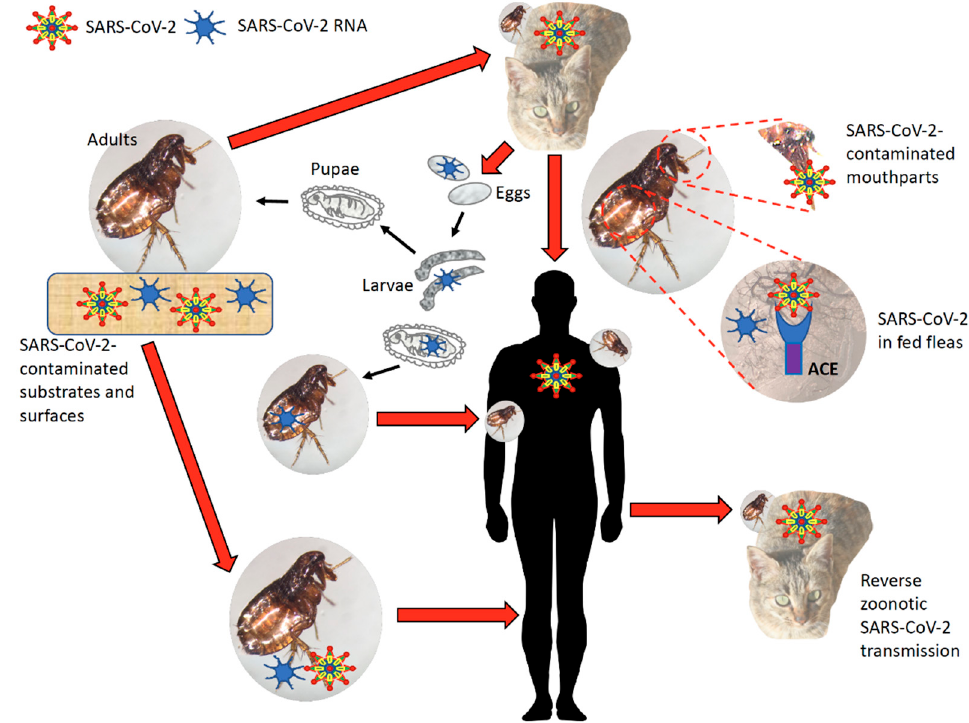
Figure 7. Proposed role of arthropod vectors in SARS-CoV-2 passive transmission. Using flea as a model, coronavirus passive transmission could occur via contact with SARS-CoV-2-contaminated substrates and surfaces. Fleas can feed on SARS-CoV-2-infected animal hosts and virus transmission to humans occurs via contaminated mouthparts, blood-meal regurgitation or inherited virus RNA. Similar to RNAi mechanisms, virus RNA may be also transmitted transovarially and transstadially. Reverse zoonotic SARS-CoV-2 transmission may also occur with arthropod passive